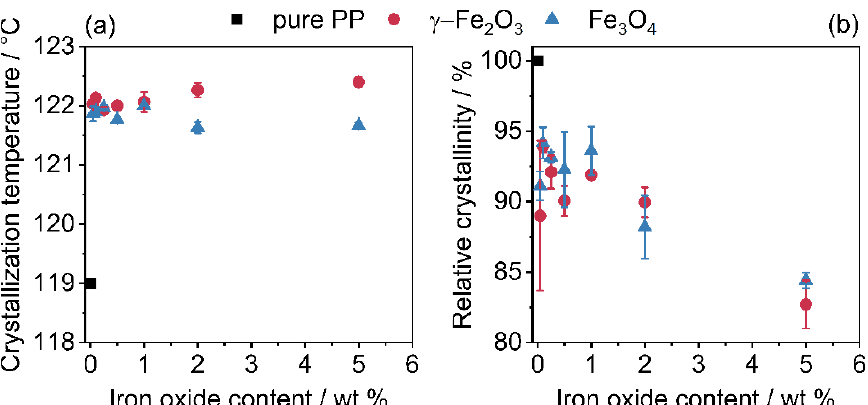
Figure 8. Change in crystallization temperature ( a ) and relative crystallinity ( b ) due to additivation with iron oxide nanoparticles. The relative crystallinity refers solely to the weight of the polymer, the SPIONs have been excluded.